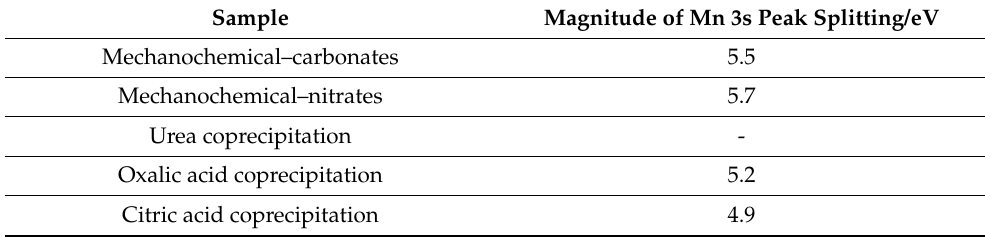
Table 4. Magnitude of Mn 3s peak splitting determined from Mn 3s XPS